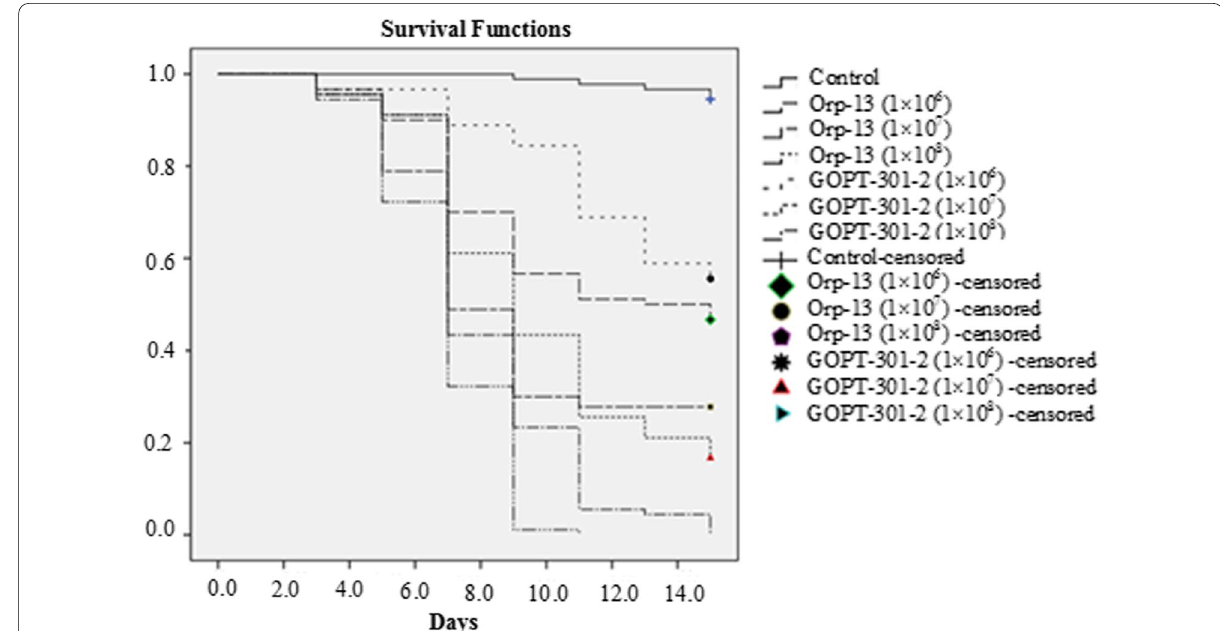
Fig. 1 Survival curve according to Kaplan–Meier analysis of Malacosoma neustria larvae exposed to different concentrations of ORP-13 and GOPT-301-2 isolates